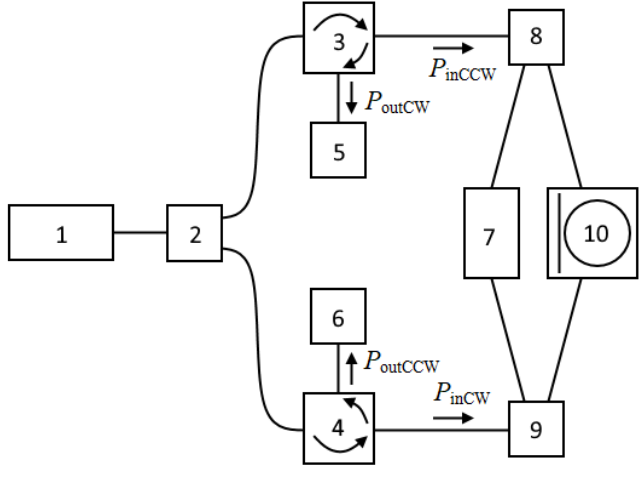
Figure 1. Schematic diagram of an optical resonator gyroscope with a resonator connected to a Mach–Zehnder modulator.